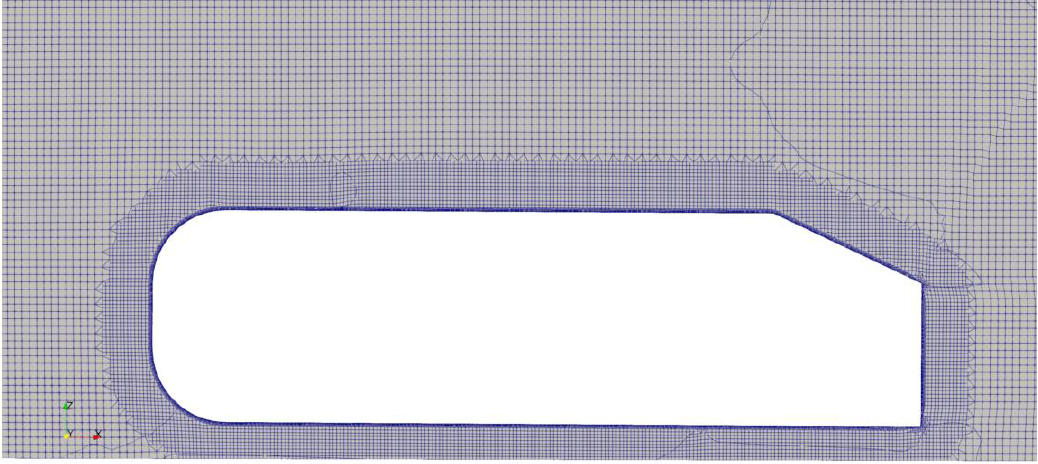
Figure 4. Expansion layers around the Ahmed Body.